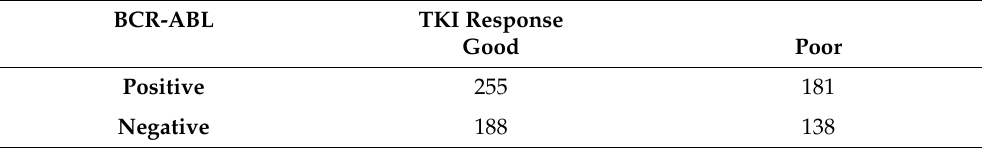
Table 1. Stem cell groups from CP-CML